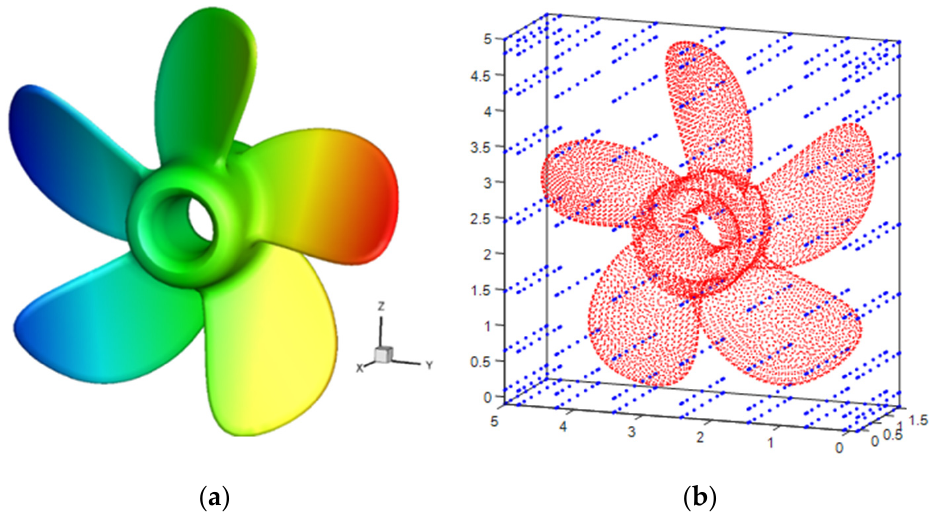
Figure 12. The profile of the five pieces fan blade domain, where “O” and “•” denote the source points (MFS) and boundary points, respectively.